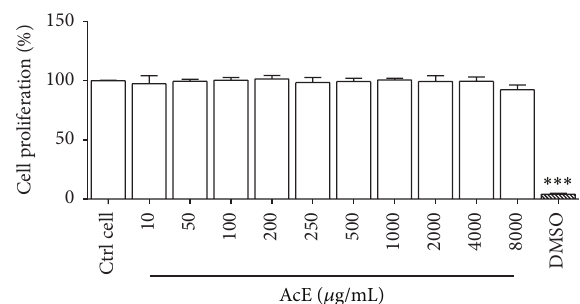
Figure 1: Effect of Allium cepa L. on cell proliferation on RAW 264.7 cells. Cells were cultured in the presence of AcE (10– 8000 𝜇 g/mL); untreated cells (Ctrl) were not exposed to AcE; and DMSO was used for positive control. After 5 days of continuous exposure, cell proliferation was assessed using Alamar blue assay. The columns represent the mean values of the results obtained of three independent experiments. There was no significance between negative control (Ctrl) and cells in all concentrations tested. There was significance between positive control (DMSO) and cells in all concentrations tested 𝑃 < 0.001 ∗∗∗